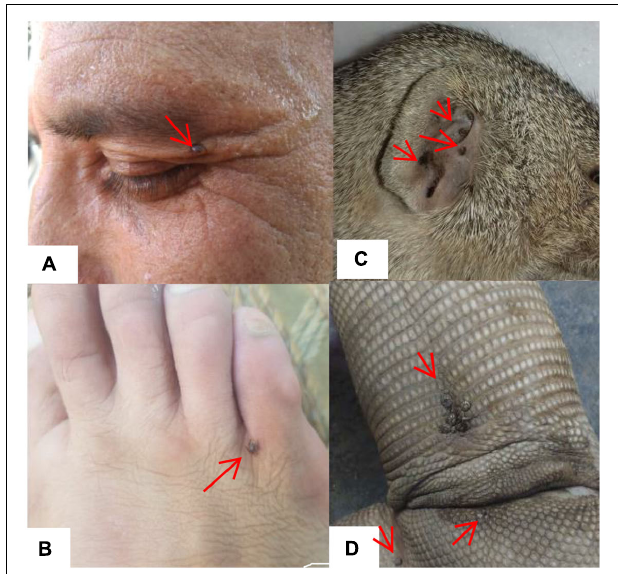
FIGURE 8 | Figure showing ticks infesting humans (A,B) (written informed consent was obtained from the individuals for the publication of images), Hae. indica collected from mongoose ( Herpestes edwardsi ) (C) , and Amb. gervaisi collected from monitor lizards ( Varanus varanus ) (D) .